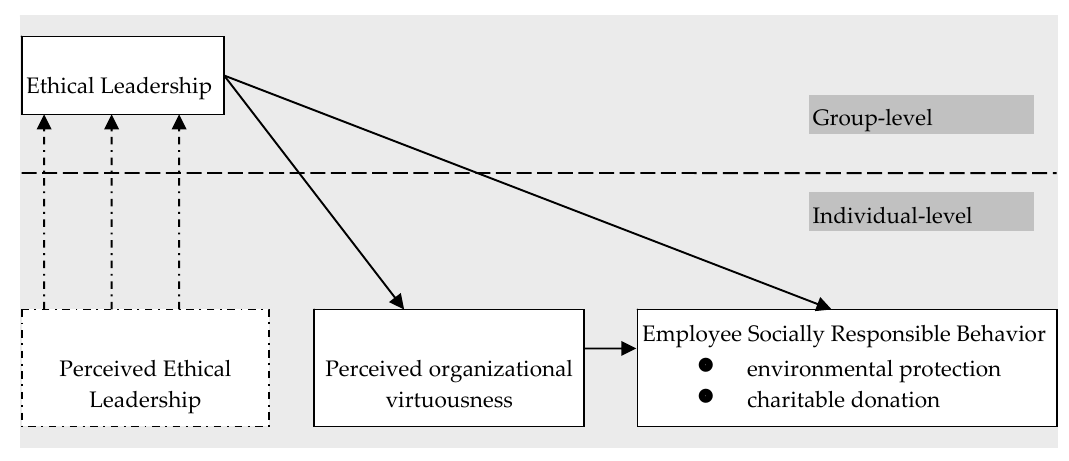
Figure 1. Theoretical Model.